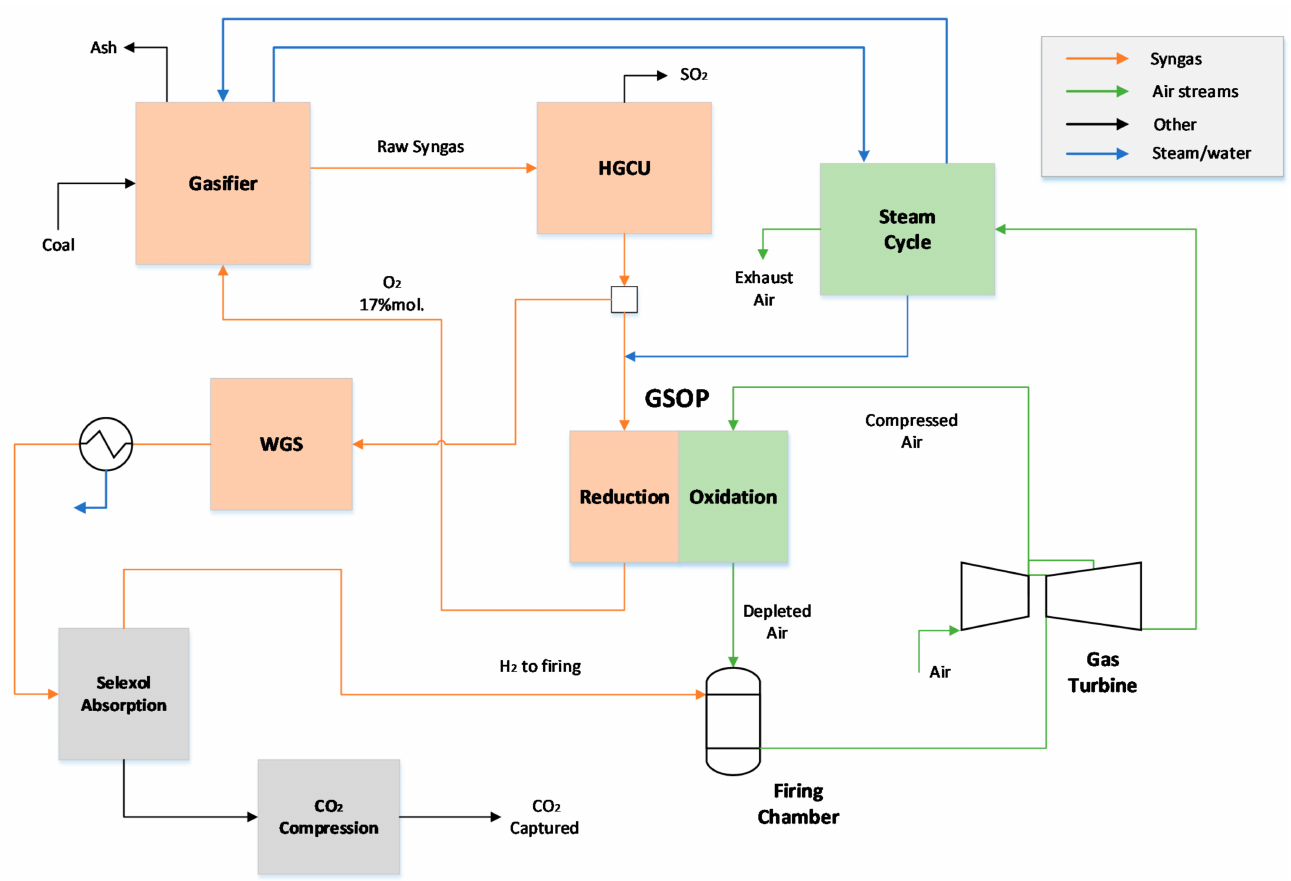
Figure 4. Schematic of the OPPC power plant (Case 5)